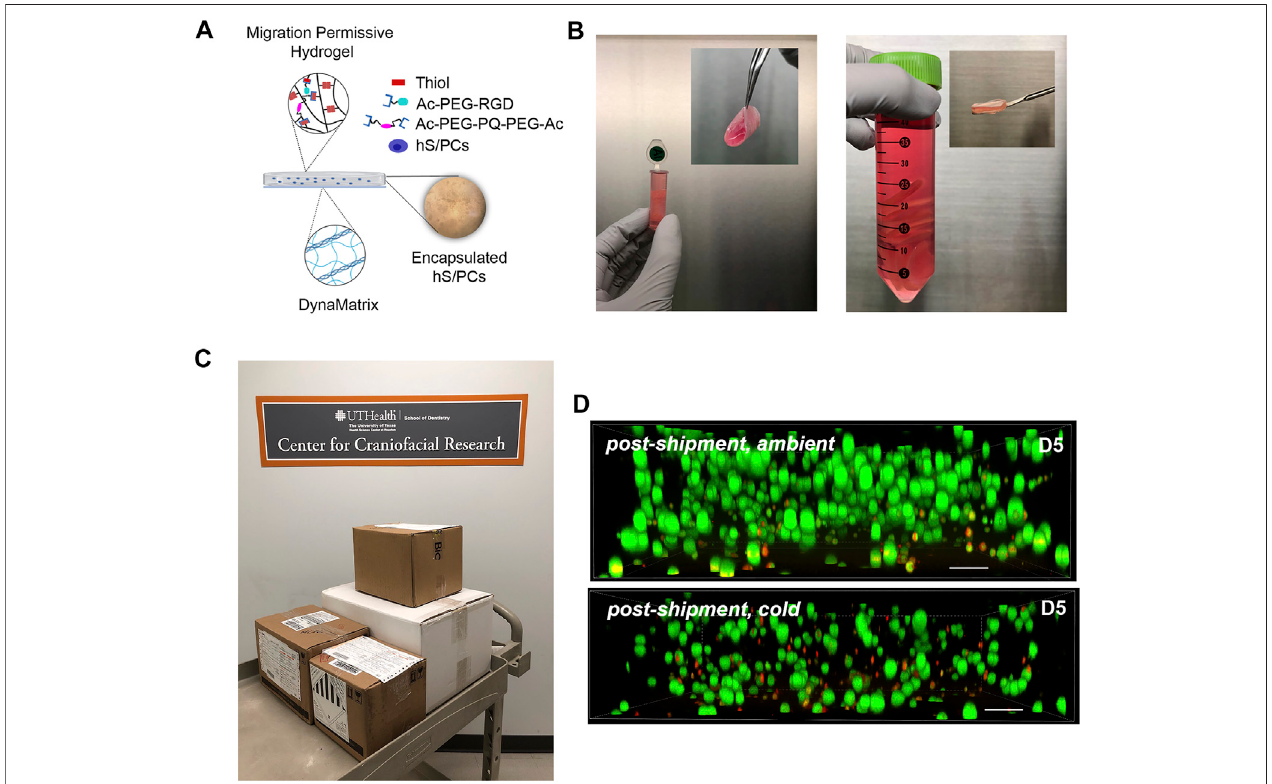
FIGURE 3 | Pre-implantation handling of the 3D-ST. (A) Composition of the 3D-ST containing migration-permissive hydrogel on the DynaMatrix ® membrane and encapsulated hS/PCs; (B) Rolled 3D-ST prepared for shipment for implant on the renal capsule using the da Vinci surgical system (left); stacked 3D-STs prepared for implantation on the parotid in open surgery (right); (C) packages prepared for overnight shipment from Houston to Pittsburgh; (D) Live/Dead assays performed on encapsulated hS/PCs after shipping priority overnight at ambient (top panel) or cold (bottom panel) temperatures. Green, live; Red, dead. Scale bars (cid:1) 200